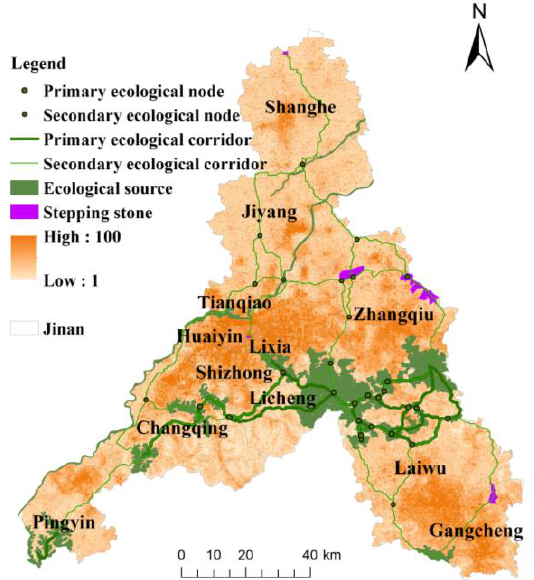
Figure 11. Optimized ecological network.